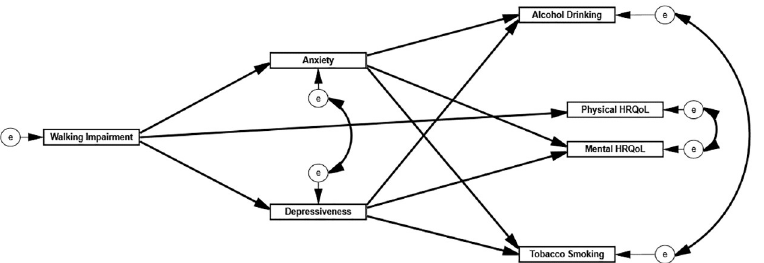
Fig 1. Theory-based path analysis model regarding the influence of walking impairment on mental burden, health risk behavior, physical and mental HRQoL in PAD